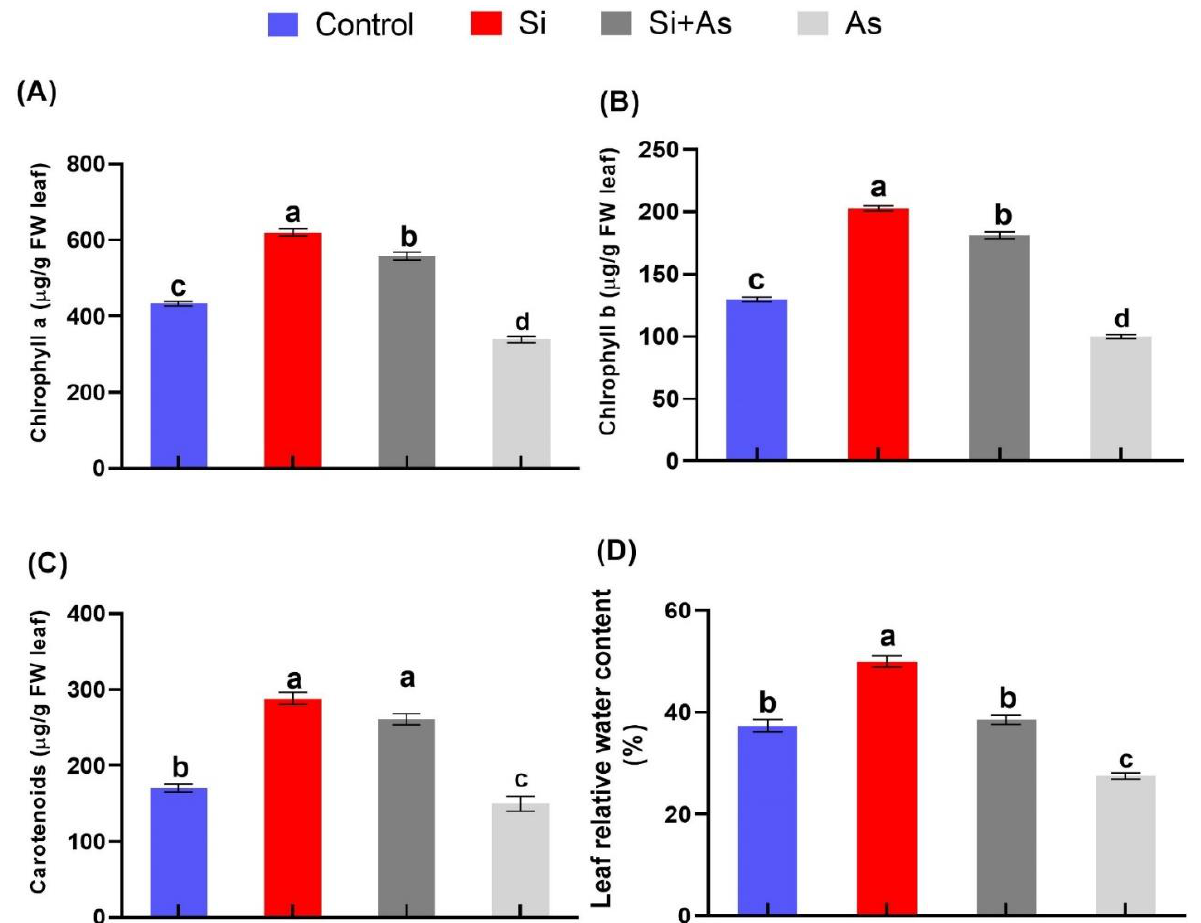
Figure 3. Influence of exogenously applied silicon (Si) on photosynthetic pigments in date palm seedlings under heavy metal stress conditions. ( A ) Chlorophyl a, ( B ) chlorophyl b, ( C ) carotenoids, and ( D ) relative water status. Different symbols show the significant difference among values ( p < 0.05). Means for all treatment values were used to determine the significant difference by performing Duncan’s multiple range test (DMRT). Values represent means (of 7 replicates) ± standard error.